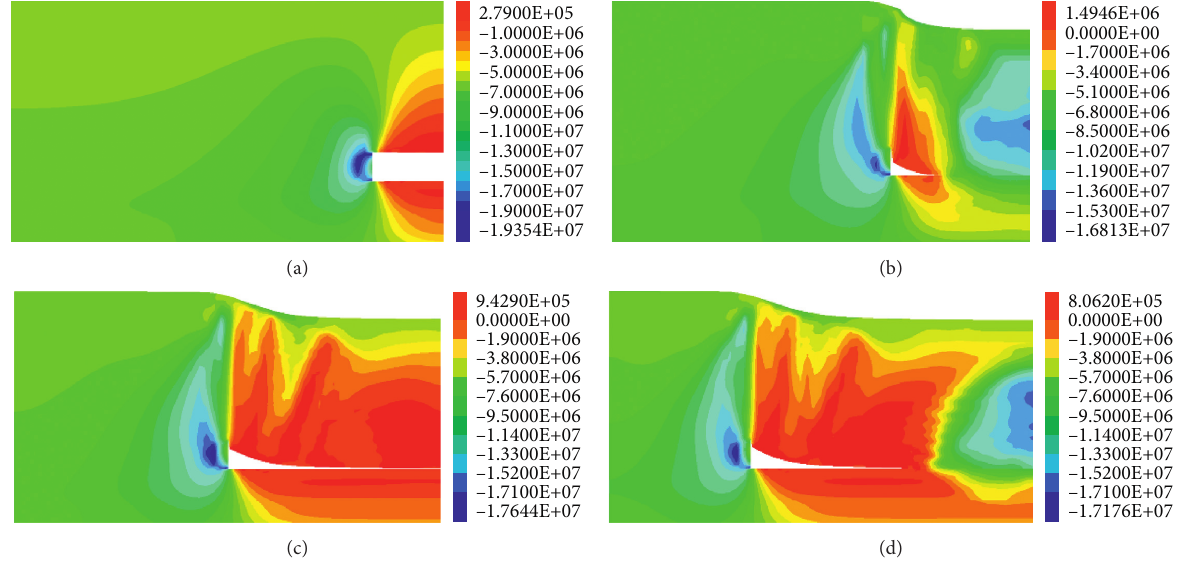
Figure 19: Vertical stress distribution of strike surrounding rock with different advancing distances. (a) Advance 50m. (b) Advance 100m. (c) Advance 150m. (d) Advance